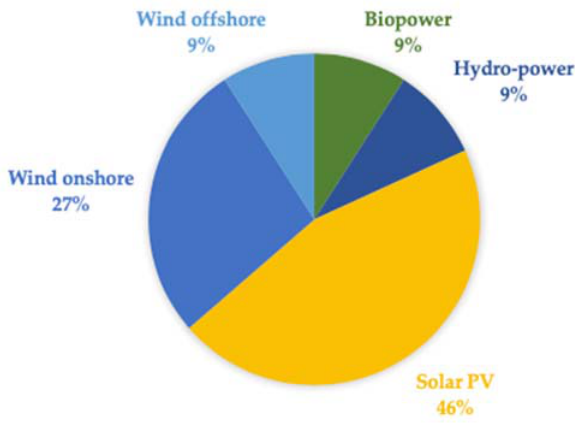
Figure 2. Share of renewable energy (RE) technologies involved in the SEP articles considering electric systems.